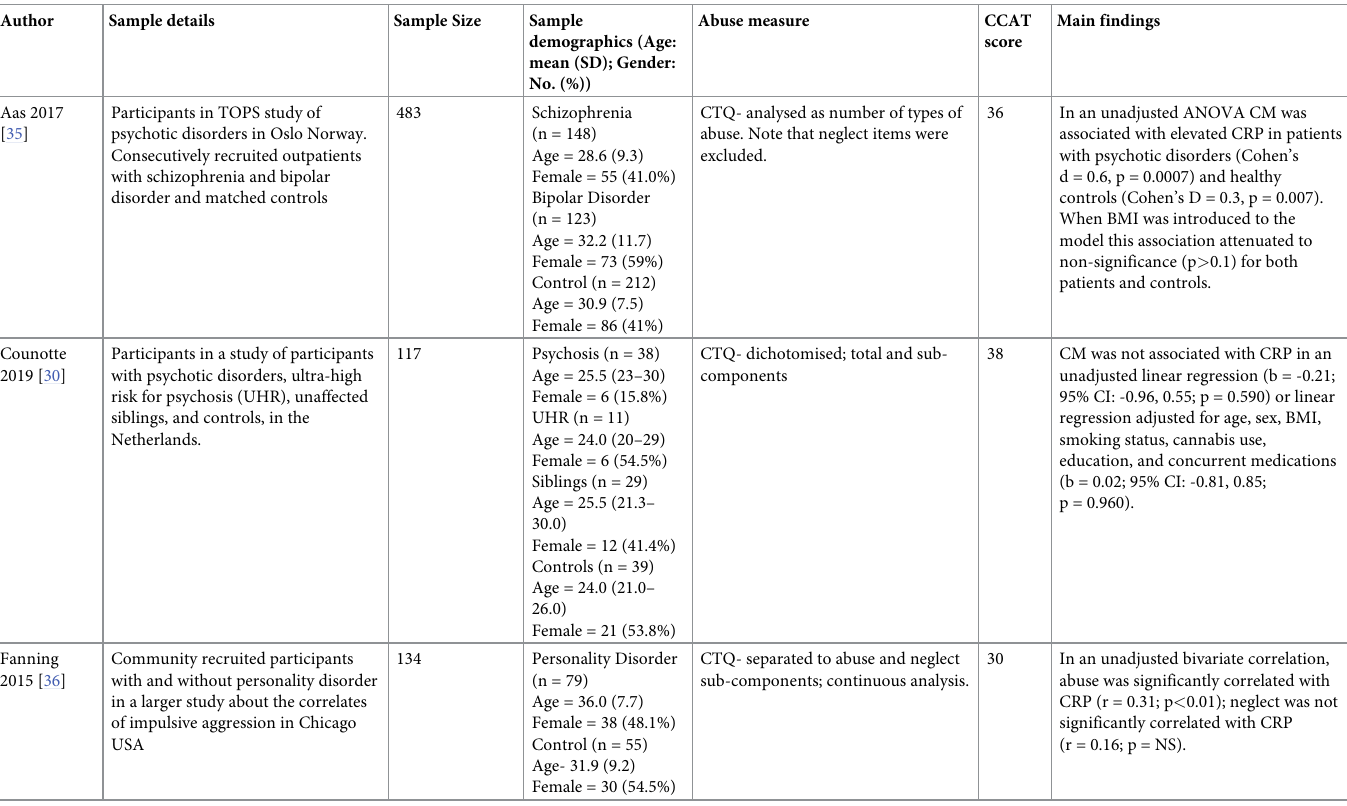
Table 2. a: Papers reporting CRP: Clinical populations. b: Papers reporting CRP: Non-clinical